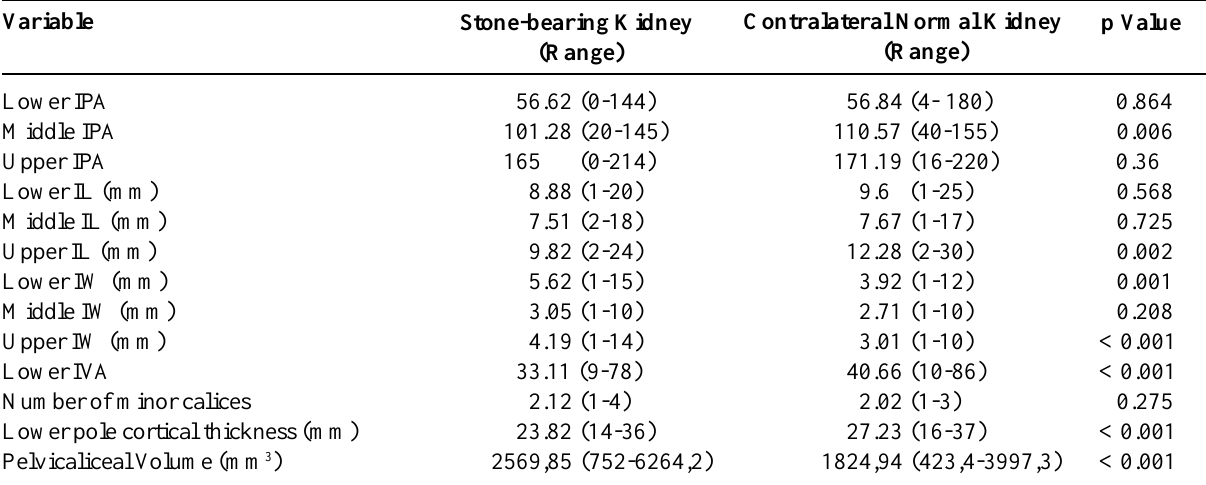
Table 1 – Comparison of pelvicaliceal anatomical variables between the stone-bearing and normal contralateral kidney.